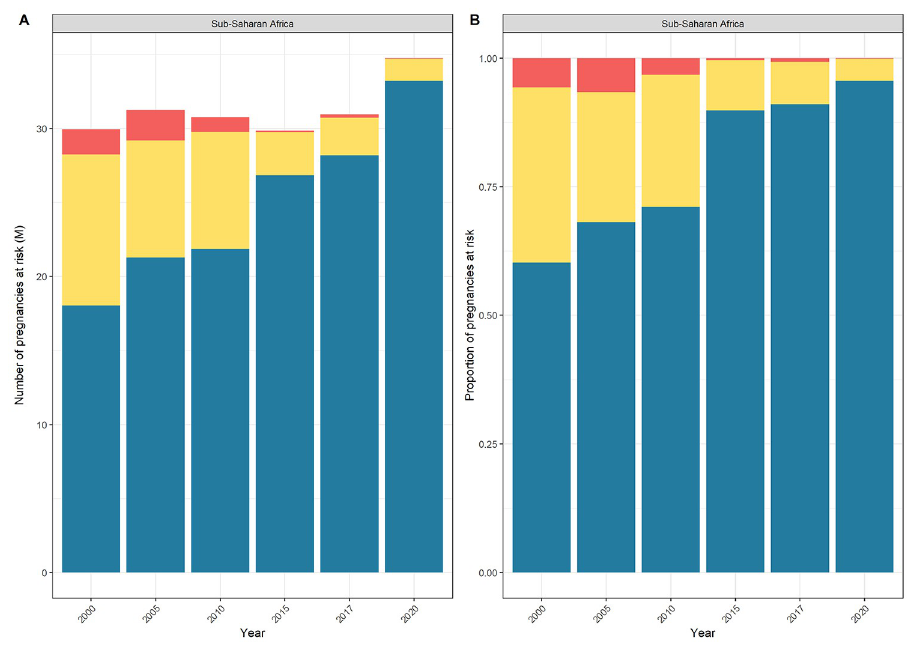
Fig 4. Number (A) and proportion (B) of pregnancies at risk of meso-endemic or higher ( � 11%) Plasmodium falciparum transmission in sub-Saharan Africa, 2000 to